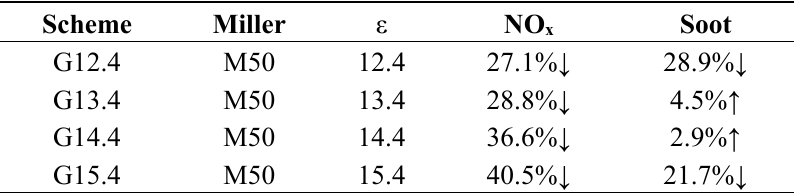
Table 4. Settings and results of high ε Miller